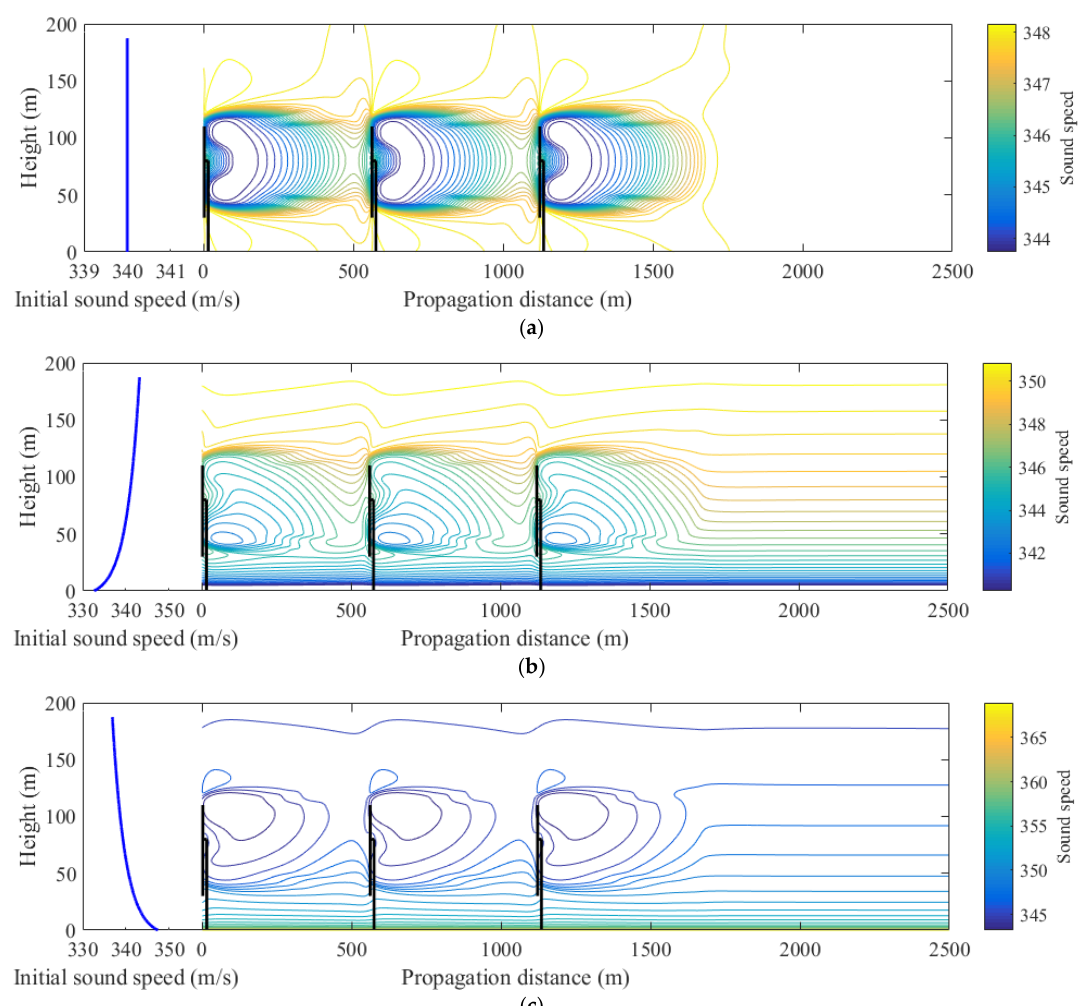
Figure 12. Initial sound speed profiles at upstream and effective sound speed contours in the wake flow. ( a ) Uniform initial sound profile transmitted into wake; ( b ) upward refraction sound profile transmitted into wake; ( c ) downward refraction sound profile transmitted into wake.